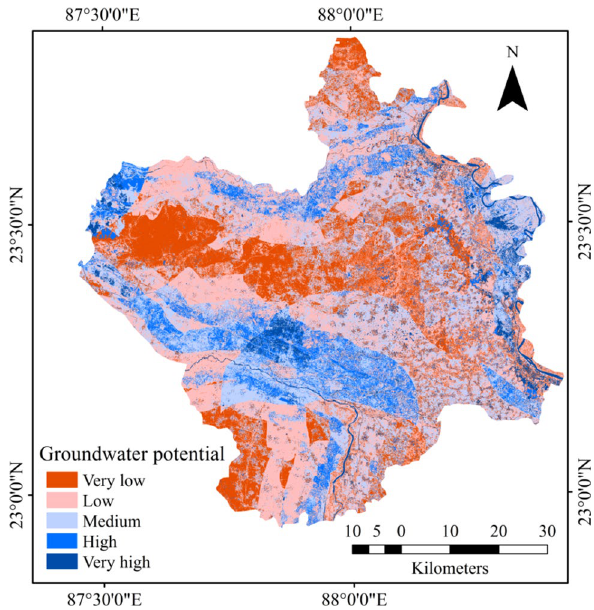
Fig. 9 Groundwater potential zone map